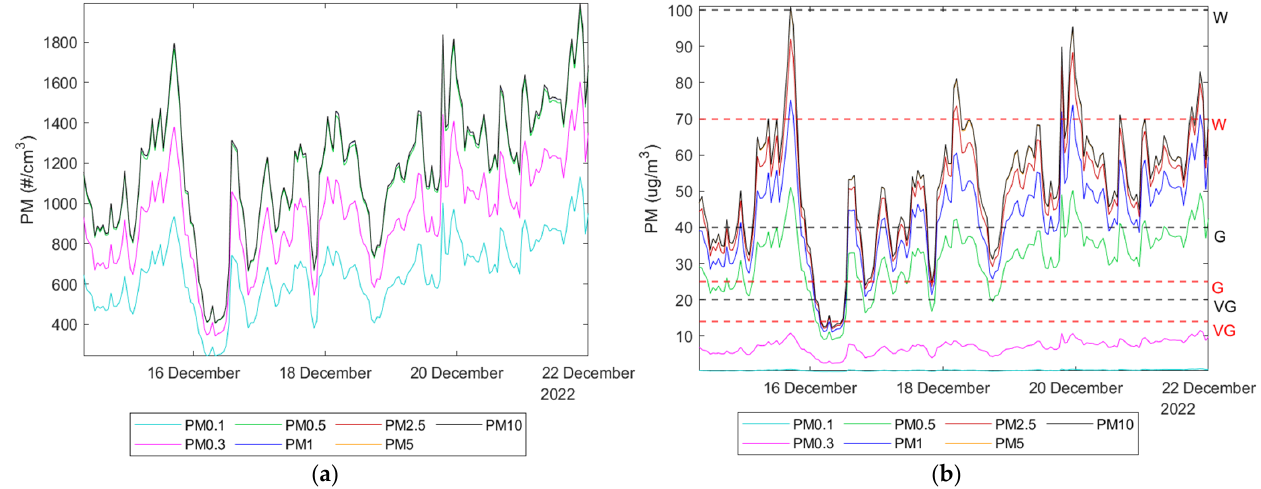
Figure 13. Hourly averages of ( a ) cumulative number concentrations of PM0.1 (cyan), PM0.3 (ma- genta), PM0.5 (green), PM1 (blue), PM2.5 (red), PM5 (yellow), PM10 (black) and ( b ) mass concen- trations of PM, where dashed lines correspond to the upper limits of very good (VG), good (G), or worsened (W) air quality for hourly mass concentrations of PM2.5 (red dashed line) and PM10 (black dashed line).